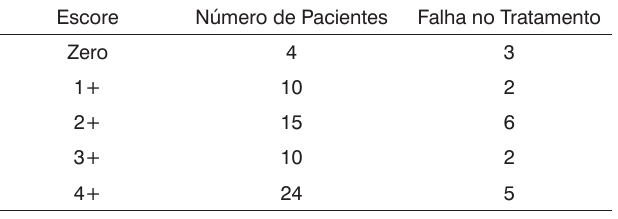
Tabela 4. Distribuição dos escores segundo presença de falha no tratamento (recidiva local ou regional, metástases e segundo tumor